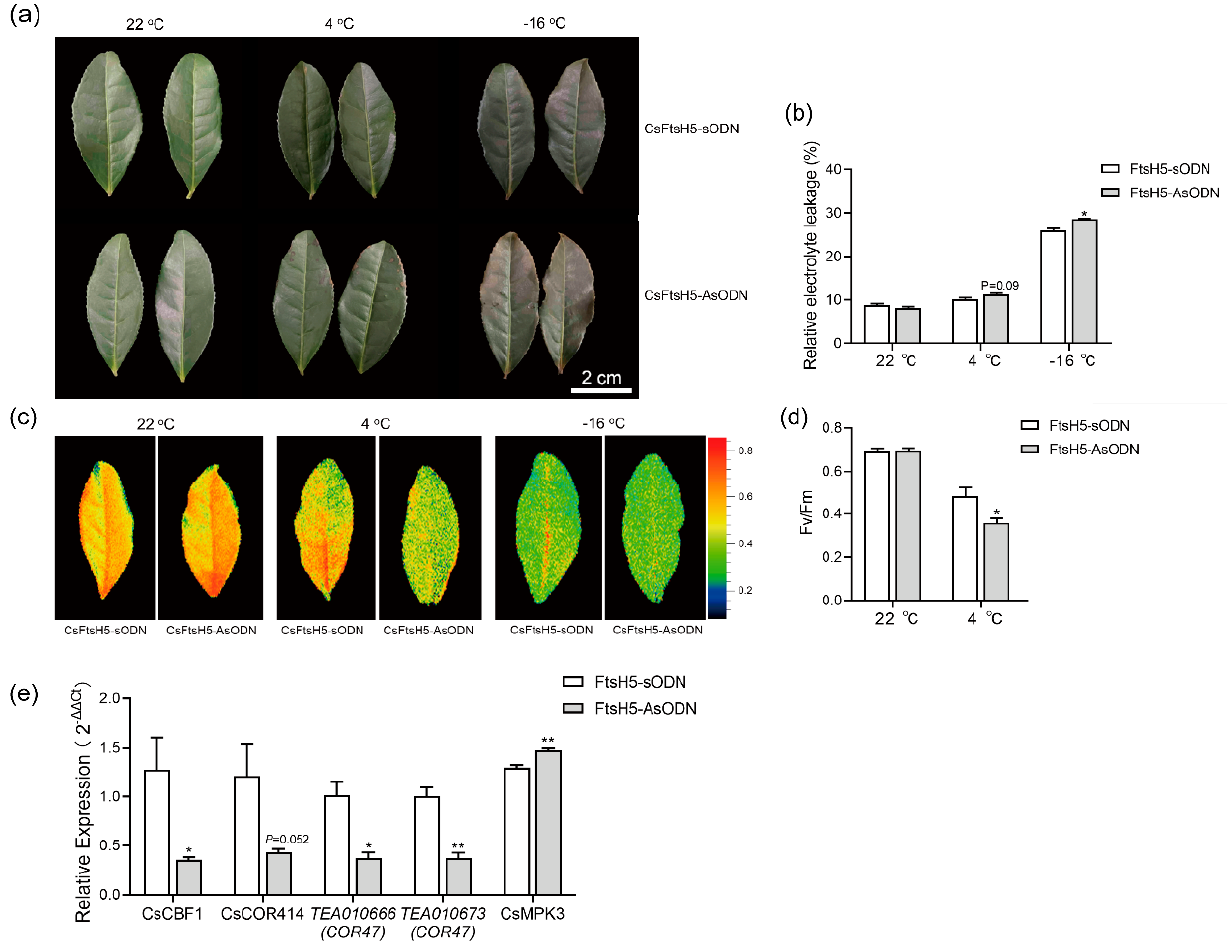
Figure 3. CsFtsH5 -AsODN tea plants showed hypersensitivity to cold stress. ( a ) Phenotypes of CsFtsH5 -AsODN and CsFtsH5 -sODN plants treated with cold stress (4 °C for 5 d followed by 22 °C recovery for 2 d) and freezing stress (22 °C for 4.5 d followed by − 16 °C for 12 h, then 22 °C recovery for 2 d). Control group was grown at 22 °C for 7 d. Scale bar = 2 cm. ( b – d ). Relative electrolyte leakage, chlorophyll fluorescence images, and Fv/Fm value of CsFtsH5 -AsODN and CsFtsH5 -sODN plants treated with low temperature. ( e ) The relative expression of CsCBF and CsCOR in CsFtsH5 - AsODN and CsFtsH5 -sODN plants under 4 °C low temperature. Mean and standard deviation values were obtained from at least three independent experiments. The asterisks indicated significantly different values between CsFtsH5 -AsODN and CsFtsH5 -sODN plants according to t -tests (* p < 0.05, ** p < 0.01).